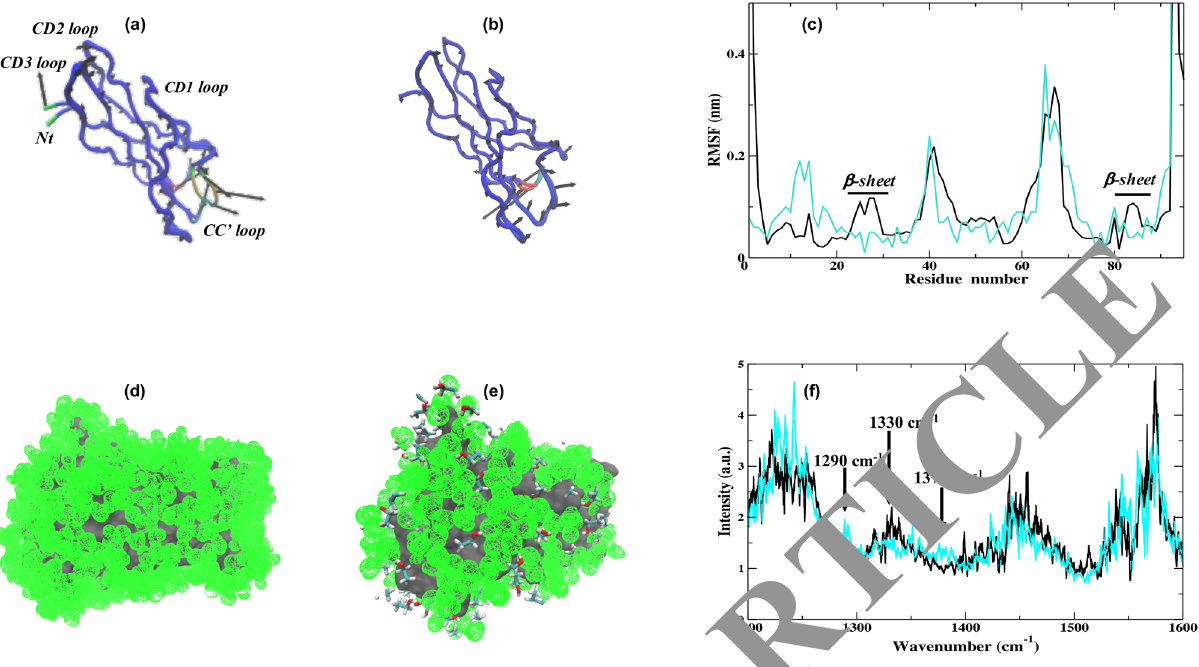
Figure 6. Dominant conformation from the FCA analysis of ( a ) the antibody in water and ( b ) the antibody in a water–ethanol solvent mixture from MD simulation. ( c ) A comparison of the RMSF (root mean square fluctuations) of the dominant conformation of the antibody in water (black) and in a water-mixed ethanol solvent (blue) from MD simulation. ( d ) The distribution of water molecules (green spheres) within a 5 Å shell of the antigen surface from the MD simulation of A6 in water and ( e ) the water (green spheres) and ethanol (licorice representation) distribution of molecules within a 5 Å shell of the antibody surface from the MD simulation of A6 in a water–ethanol mixed solvent. ( f ) The calculated H-bonding spectrum of water-protein interactions from the MD simulation of antibody A6 in water (black line) and in a water–ethanol solvent environment (cyan